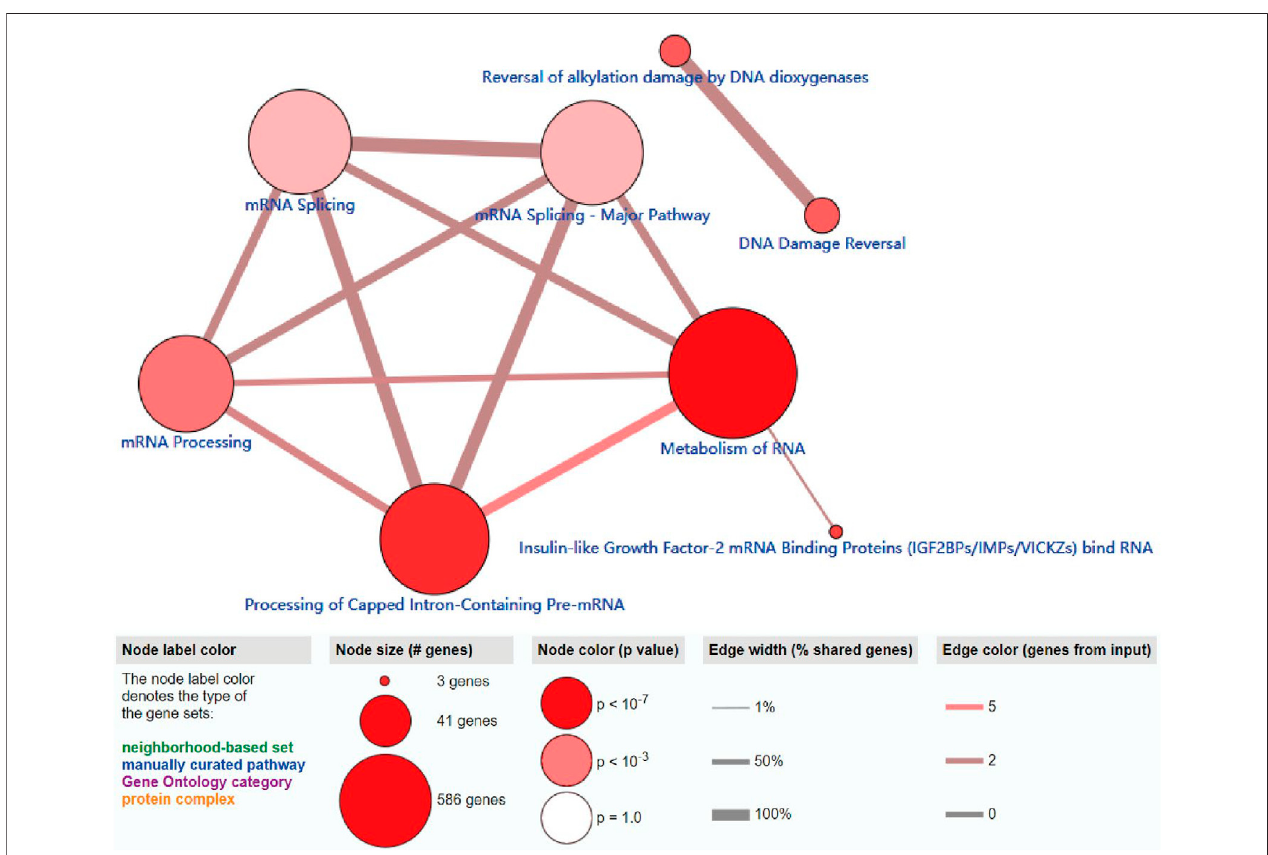
FIGURE 5 | ConsensusPathDB analysis of functional enrichment of m6A-related regulators. The node label color denotes the type of the m6A-related regulators.